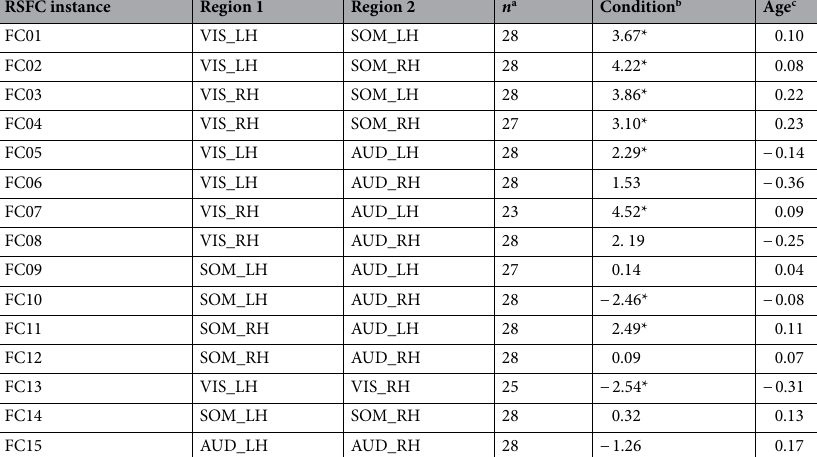
Table 1. Summary of statistical analyses ( t and r values) in Study 1. RSFC = resting-state functional connectivity; FC = functional connectivity; VIS = visual region; LH = left hemisphere; SOM = somatosensory region; RH = right hemisphere; AUD = auditory region. a Sample size after outlier removal. b Positive t values indicate that the mean was higher in the eyes closed condition than in the eyes open condition, whereas negative t values indicate that the mean was lower in the eyes closed condition than in the eyes open condition. c Positive r values indicate that the mean difference between the eyes closed condition and the eyes open condition was higher with increasing age, whereas negative r values indicate that the mean difference between the eyes closed condition and the eyes open condition was lower with increasing age. * p < .050 (FDR